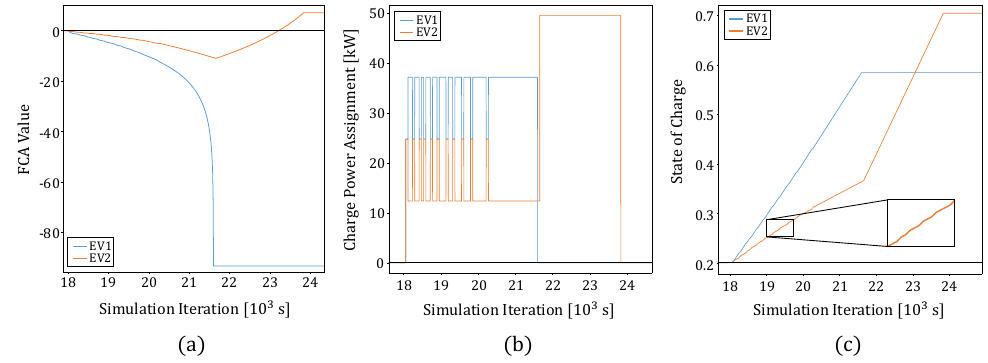
Figure 11. Double Split by Preferences. ( a ) Feeding Compensation Account, ( b ) Charge Power, ( c ) State of